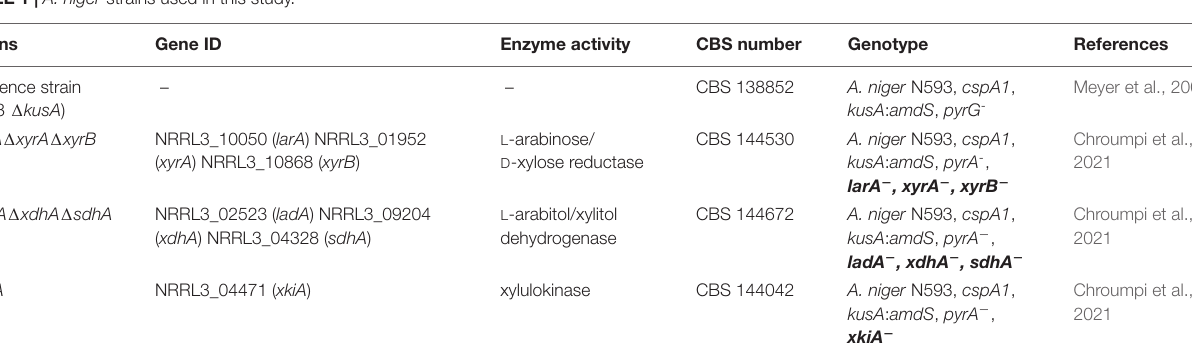
FIGURE 2 | Gene Ontology (GO) terms associated with the function of genes upregulated or downregulated during growth on sugar beet pulp (SBP) and wheat bran (WB) in the A. niger reference strain (N593 (cid:49) kusA ) and the PCP deletion mutants. The size and color of the circles represent the number of genes and statistical significance of enriched GO terms, respectively. TABLE 1 | A. niger strains used in this